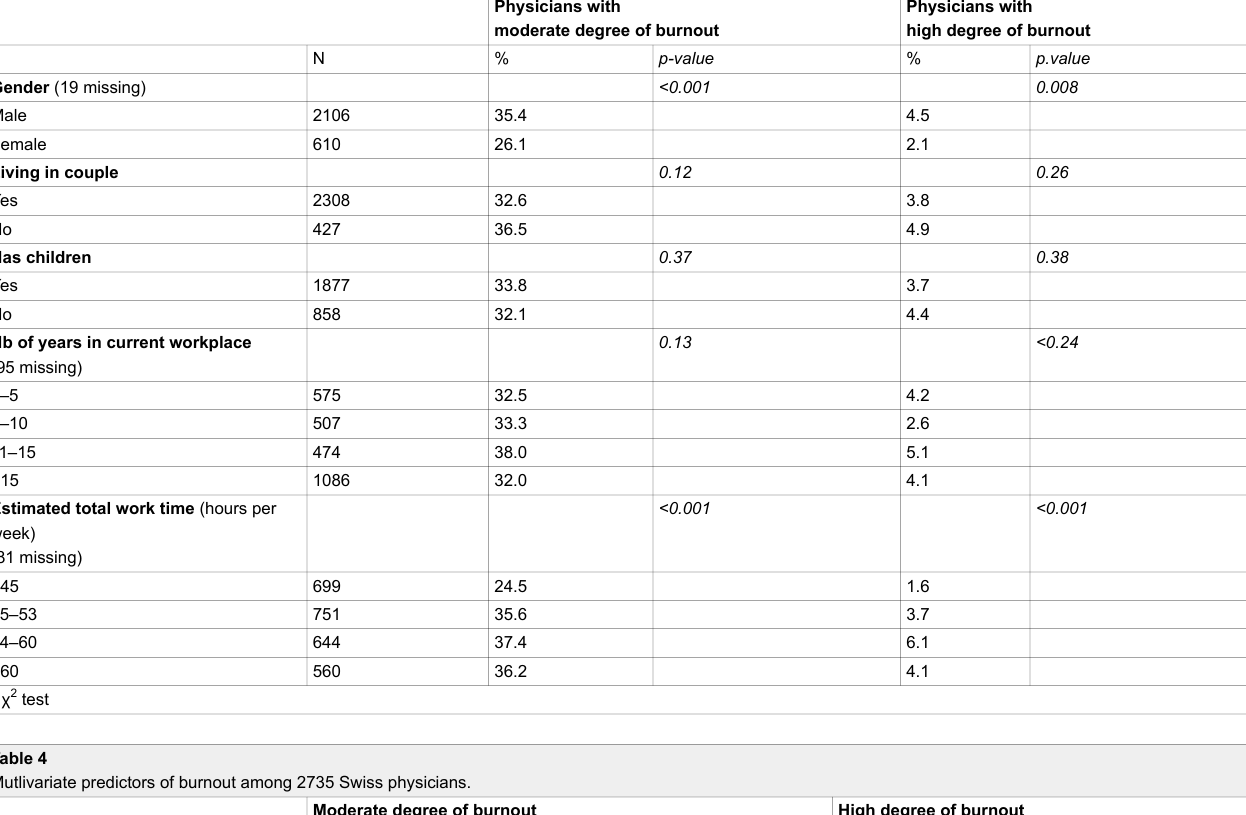
Table 3 Relationships between socio-demographic characteristics and burnout among 2735 Swiss general practitioners, paediatricians, internal medicine specialists and cancer clinicians.